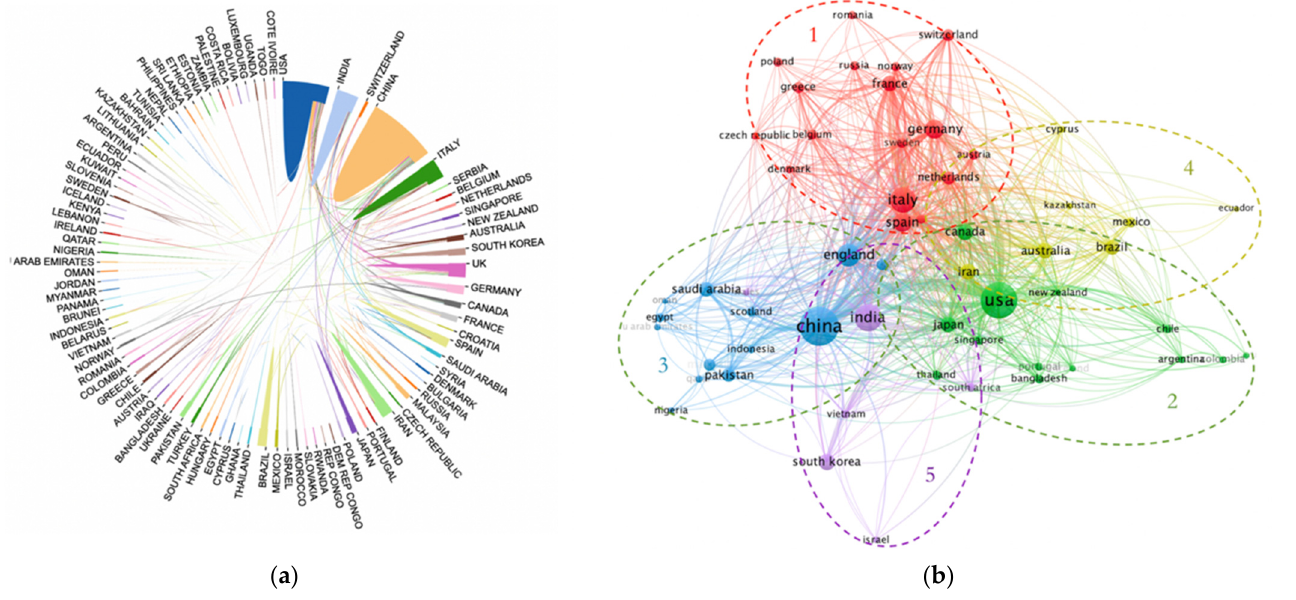
Figure 3. ( a ) Country partnership chart; ( b ) Country partnership clustering chart.